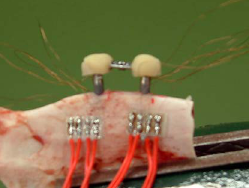
Fig. 3 Strain gauges are adhered on the neck of the